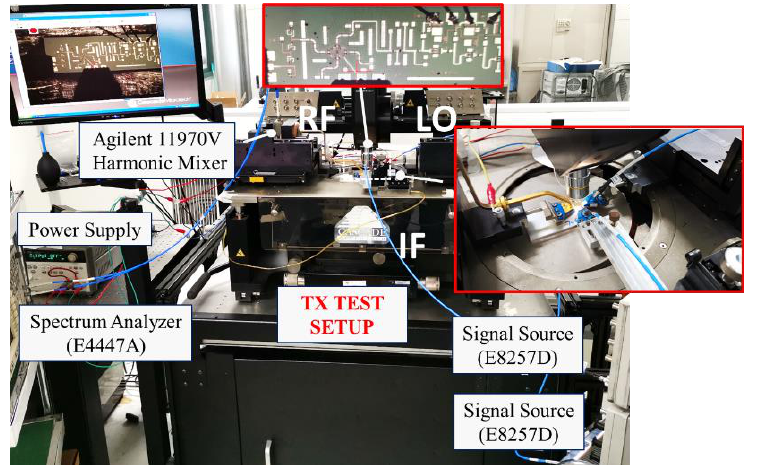
Figure 13. On-chip measurement setup.